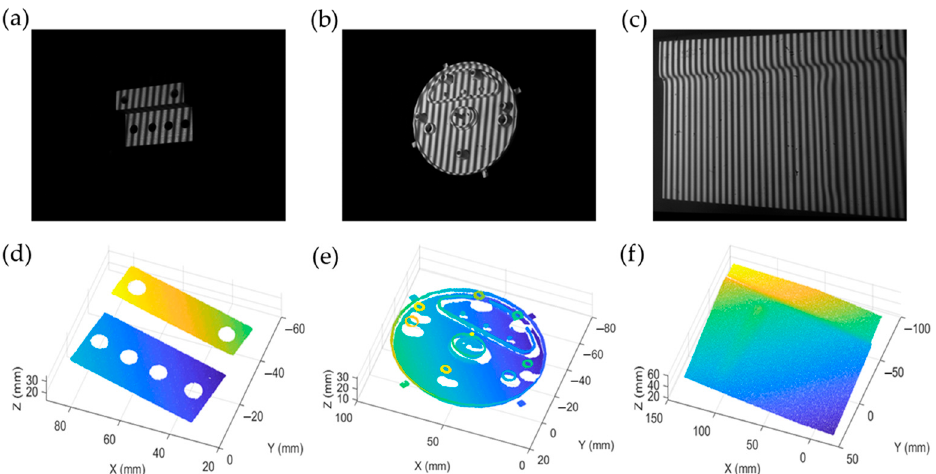
Figure 9. Reconstruction results of the standard ball plate: ( a ) physical map, ( b ) schematic diagram of size, and ( c ) 3D measurement result.